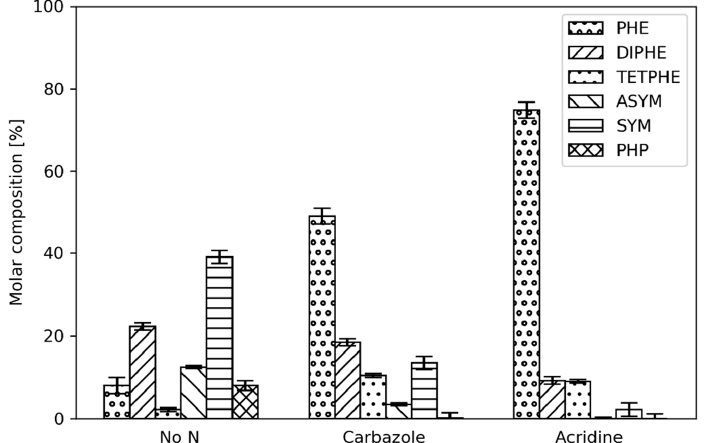
Figure 3. Phenanthrene product distribution with 1.2 mmol/dm 3 organic nitrogen (carbazole or ac- ridine) present in the reactant feed at a reactor temperature of 280 °C.